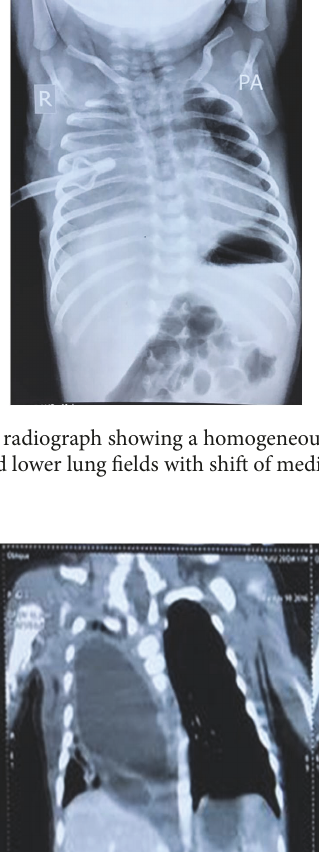
Figure 4: Microphotograph showing scanner view of the cyst wall showing double layered intestinal wall with normal intestinal mucosa and pancreatic rests within the muscularis (Hematoxylin & Eosin,